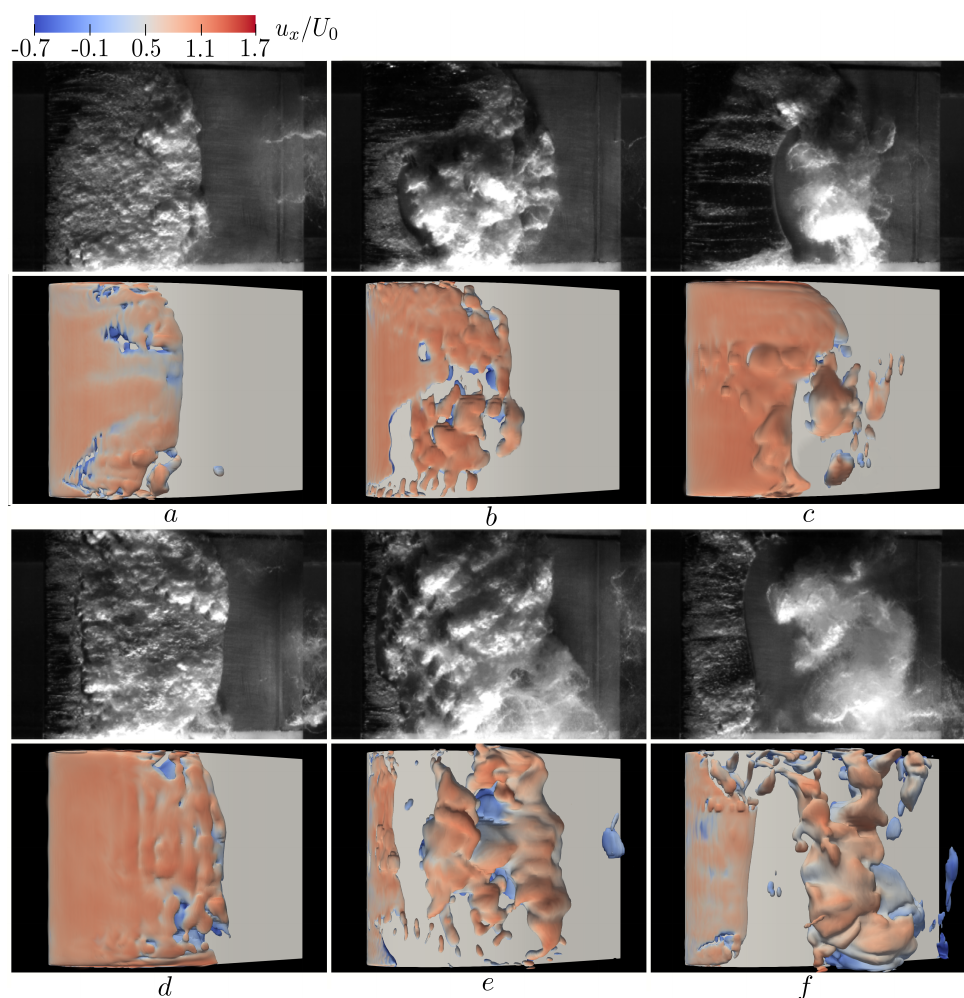
Figure 8. Comparison of cavitation structures at six characteristic time instants ( a – f ) colored with the streamwise velocity u x for regime I: snapshots captured in experiment (top row) and isosurface (cid:101) α = 0.5 from LES using Schnerr-Sauer model and LUDS discretization scheme (bottom row). Right column is a top view of the same cavitation patterns shown in the middle